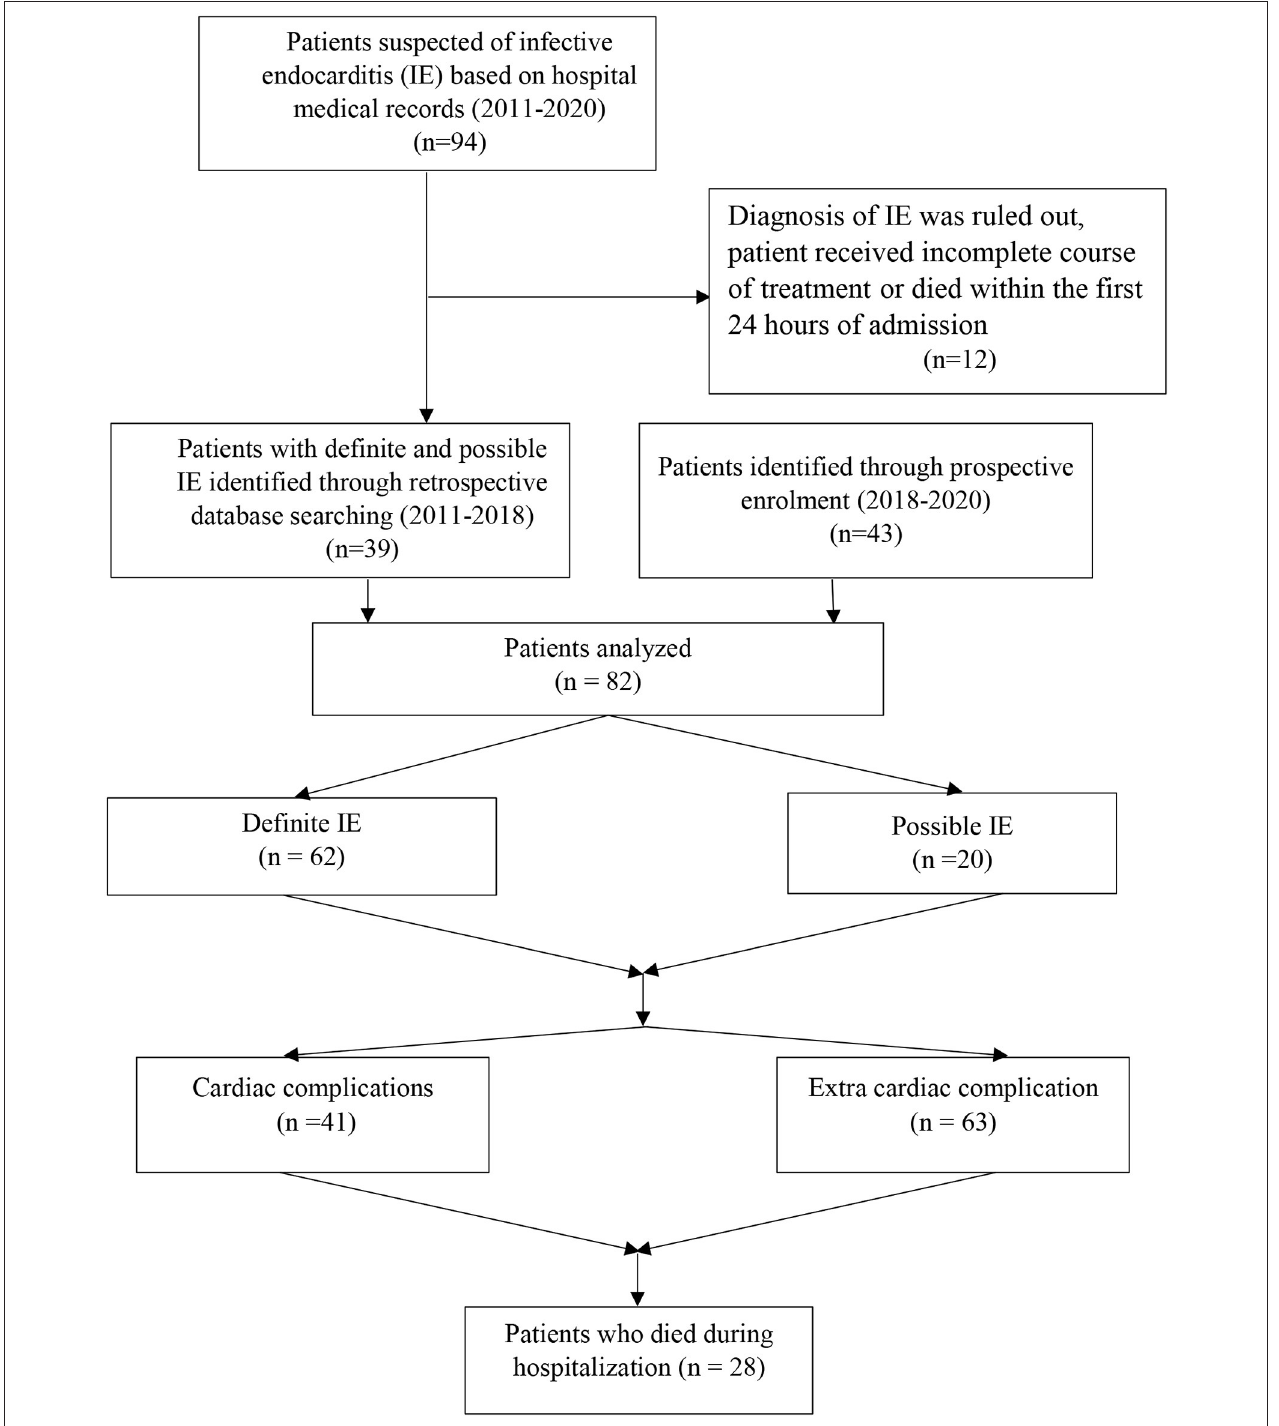
FIGURE 1 | Enrolment protocol of patients with definite or possible infective endocarditis.